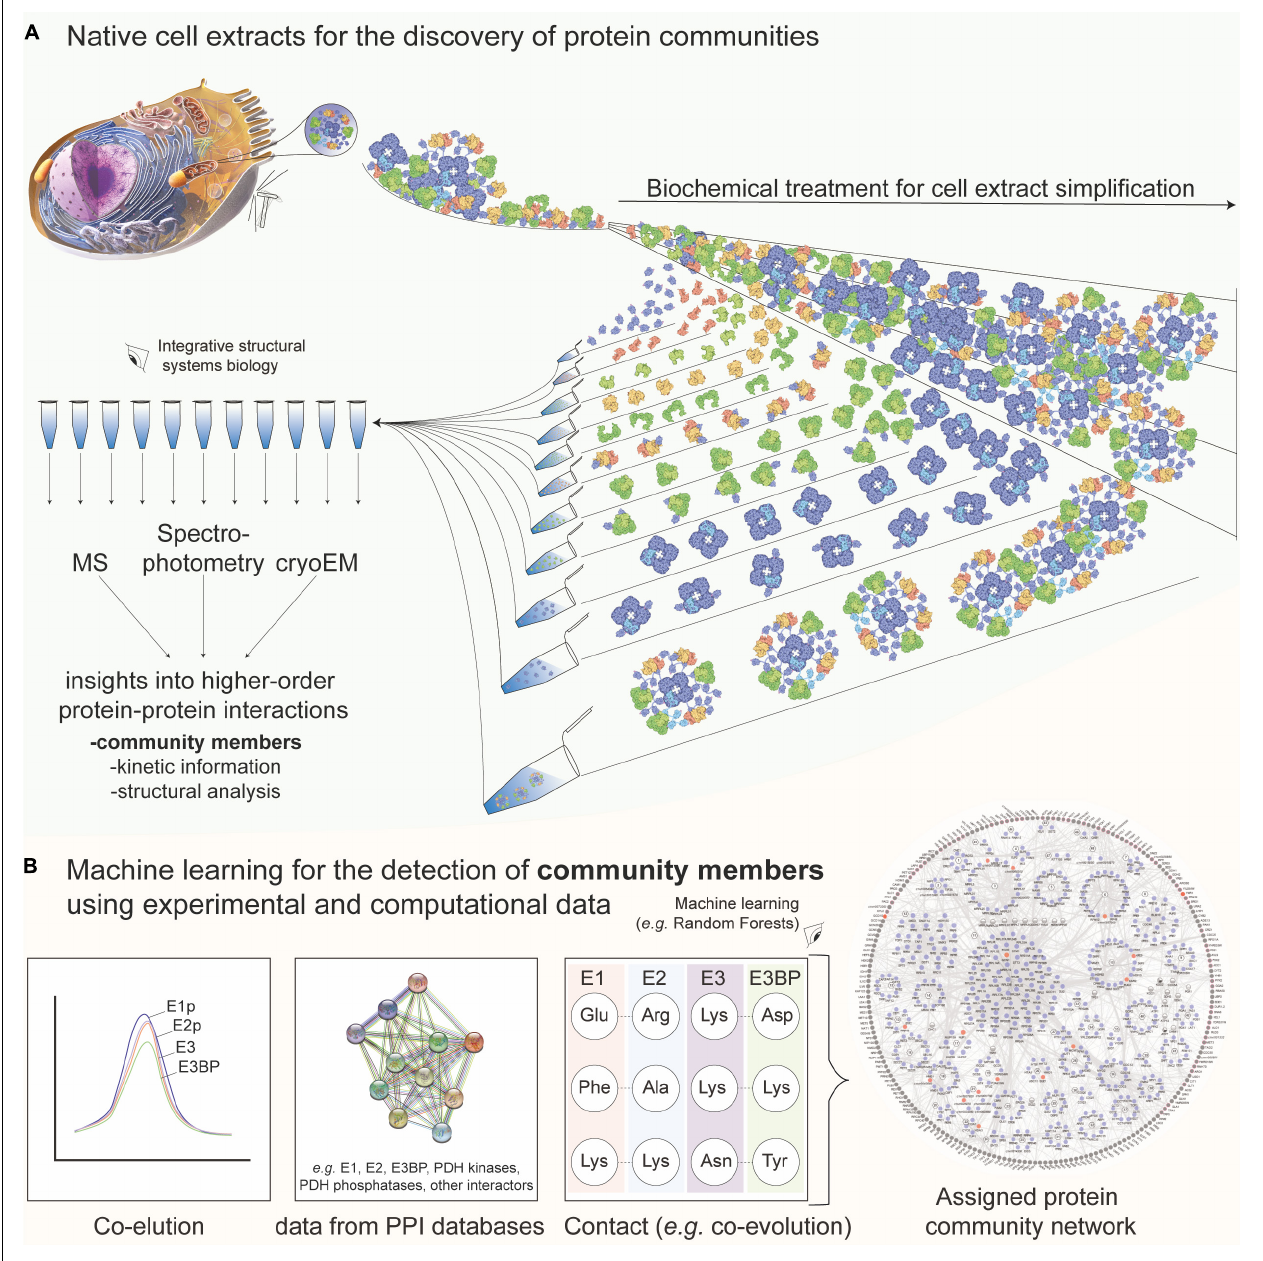
FIGURE 1 | Native cell extracts as a tool for discovering protein communities with the aid of machine learning. (A) Methods to experimentally extract identity, structure, and dynamics information of protein communities. In short, the cell is lysed and the subsequent fractionation is applied to recover co-eluting protein material. In a large-scale manner, mass spectrometric, kinetic, and cryo-EM analysis of the fractions leads to the characterization of protein communities in native cell extracts. The example of the pyruvate dehydrogenase complex (PDHc) metabolon is shown. Molecular representations for PDHc are retrieved and further edited from Protein Data Bank “Molecule of the Month” section [Source: Image from the RCSB PDB September 2012 Molecule of the Month feature by David S. Goodsell (doi: 10.2210/rcsb_pdb/mom_2012_9)]. The cell representation on the top left was retrieved from Microsoft PowerPoint 2019 v16.47. (B) Combined data regarding protein–protein interactions stemming from fractionation (co-elution), external database information (network data), and contact information prediction (e.g., from co-evolution analysis, chemical cross-linking or mutagenesis experiments) among community members are used for machine learning, e.g., using a random forest. Finally, a network with interconnected protein communities is derived and insights into community members can be retrieved. External data shown are extracted from STRING (https://string-db.org/) and network shown from Kastritis et al. (2017). E1, E2, E3, and E3BP are the proteins structuring the 10-MDa complex of the PDHc metabolon, all involved in the complex reaction of pyruvate